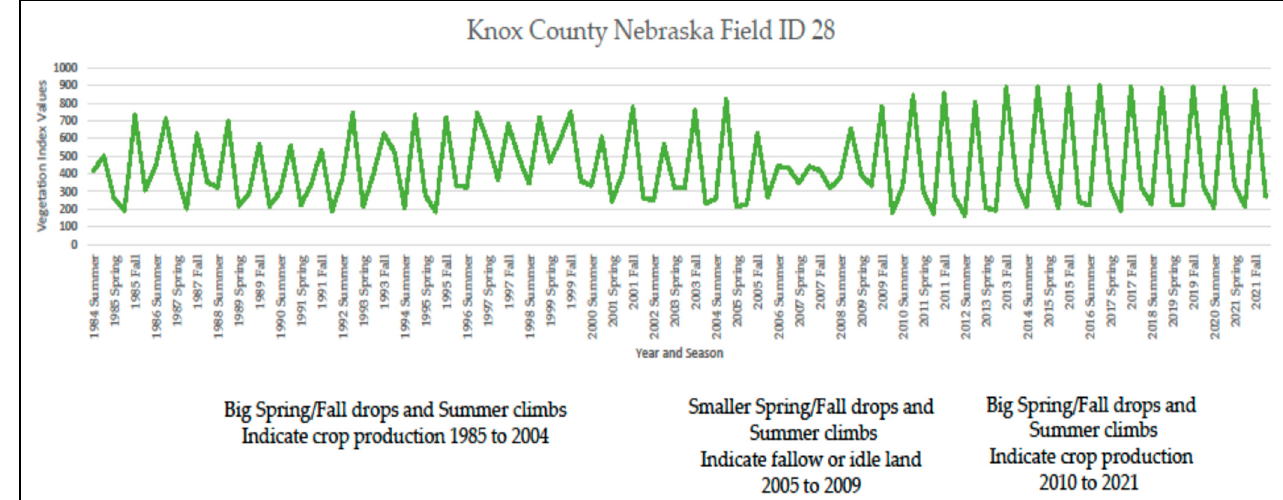
Figure 12. LandTrendr temporal signature for a field that was identified as change from grass to crop between 2008 and 2020 but showed signs of cropland in earlier years.